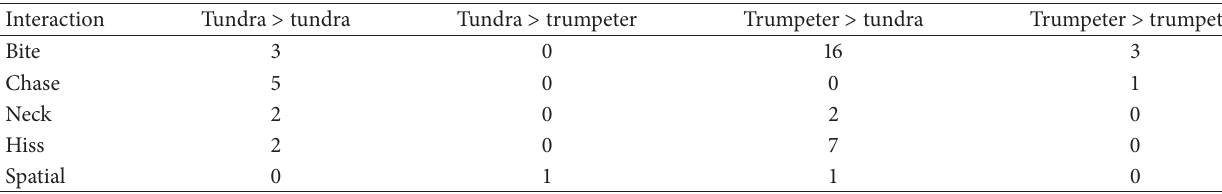
Table 3: Inter- and intraspecific aggression between and among tundra and trumpeter swans while feeding on sago pondweed tubers. Swans were observed feeding in mixed flocks for 23.5 h. Interactions always resulted in the target individual moving away. Swans actively displaced each other through bites and chases and often threatened with outstretched necks or a hiss. Occasionally, they would passively displace each other by passively occupying the space of a foraging swan (“spatial”). A > B denotes that A wins in an aggressive encounter. Interaction Tundra > tundra Tundra > trumpeter Trumpeter > tundra Trumpeter > trumpeter